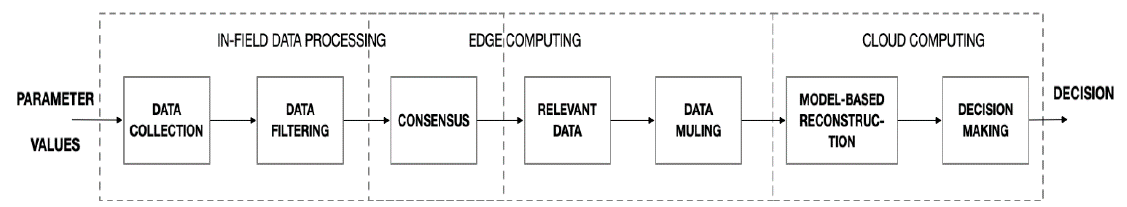
Figure 5. Flow diagram of the data processing at the system level.